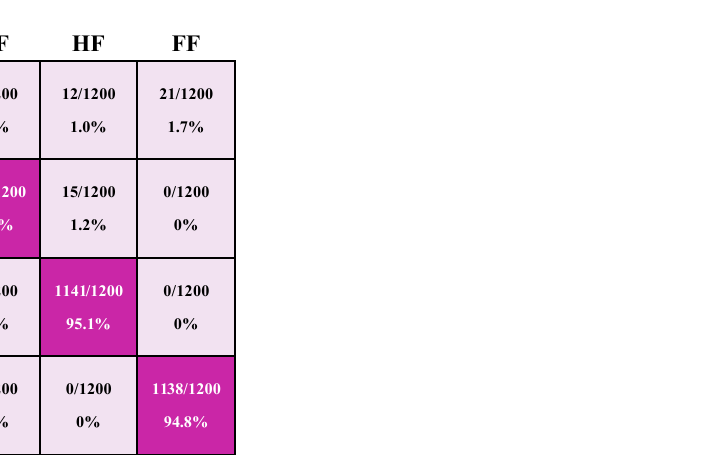
Figure 9. Parametric optimization of contour map by quadratic grid search method: ( a ) parameter selection for initial grid partitioning and ( b ) parameter selection of secondary meshing.